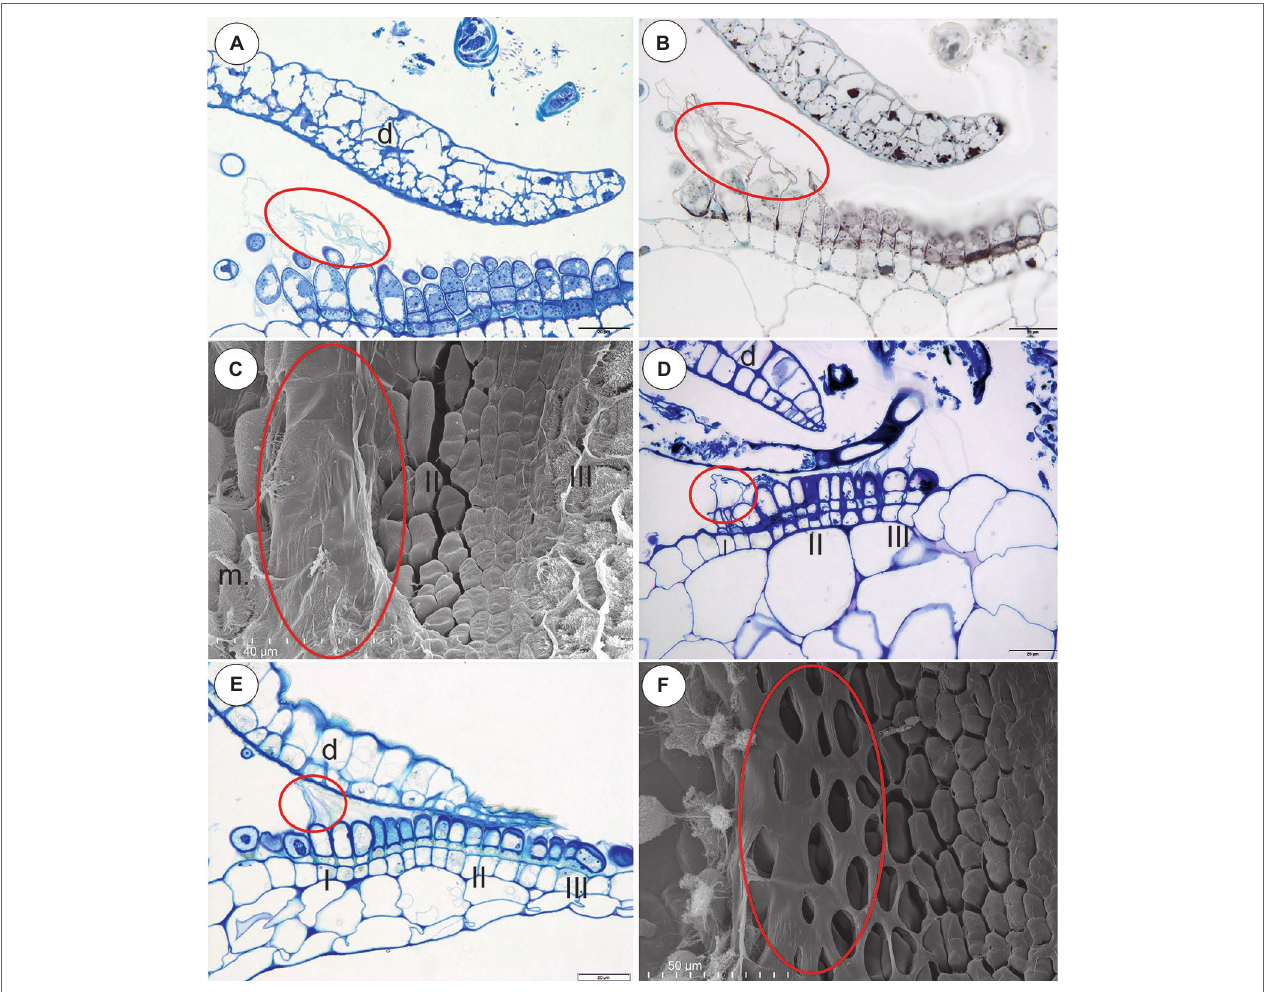
FIGURE 5 | Structure of the pavement epithelium and velum of Utricularia species; section Oligocista ( U. prehensilis ) and section Foliosa ( U. calycifida , U. tricolor ). (A) A semi-thin longitudinal section of the pavement epithelium of Utricularia prehensilis ; the velum (ellipse); scale bar = 20 μ m. (B) U. prehensilis , a semi-thin longitudinal section of the threshold of the external part showing the trichomes that produce the velum (ellipse). The lipid stain SBB was absorbed by the cuticles and the lateral walls of the barrier cells; scale bar = 20 μ m. (C) Utricularia calycifida , scanning electron microscope image of the pavement epithelium, note the velum that covers zone one (ellipse), the middle zone (II) and the internal zone (III) with the mucilage trichomes and the sessile mucilage trichomes at the front of the pavement epithelium (m); scale bar = 40 μ m. (D) A semi-thin longitudinal section of the pavement epithelium of Utricularia calycifida , note the three zones of the pavement epithelium (I, II, III), the velum (circle); scale bar = 20 μ m. (E) A semi-thin longitudinal section of the pavement epithelium of Utricularia tricolor , note the three zones of the pavement epithelium (I, II, III), the velum (circle); scale bar = 20 μ m. (F) Utricularia prehensilis , SEM image of the pavement epithelium, note the honeycomb-like velum (ellipse); scale bar = 50 μ